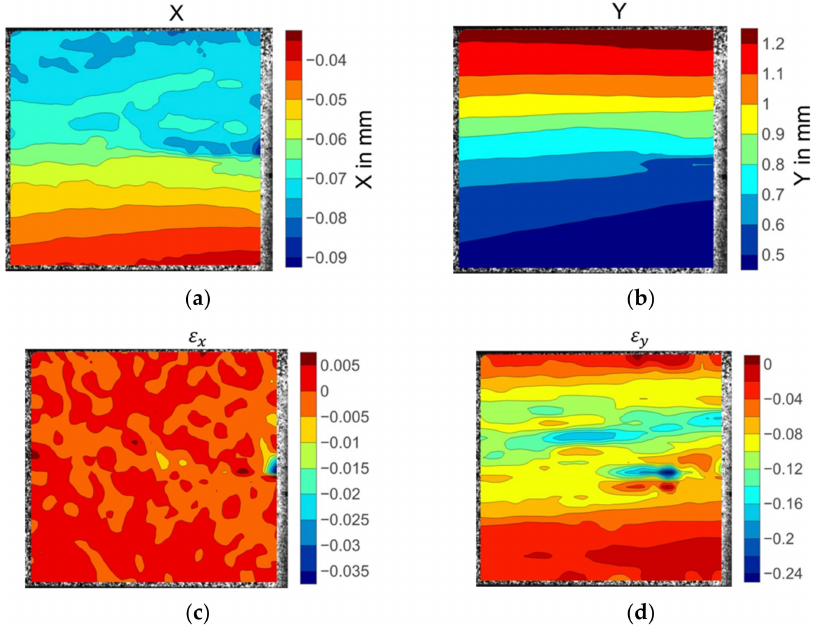
Figure 14. The displacement and strain field contour plots of the 90 ◦ on-axis transverse compression specimen: ( a ) Displacement in the X direction; ( b ) displacement in the Y direction; ( c ) strain in the X direction; ( d ) strain in the Y